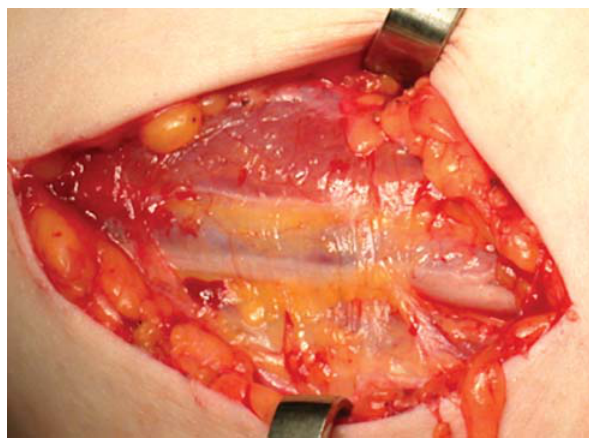
Fig. 4 Connective tissue that comprises the MBFC and encloses the neurovascular bundle. MBFC, medial brachial fascial compartment.